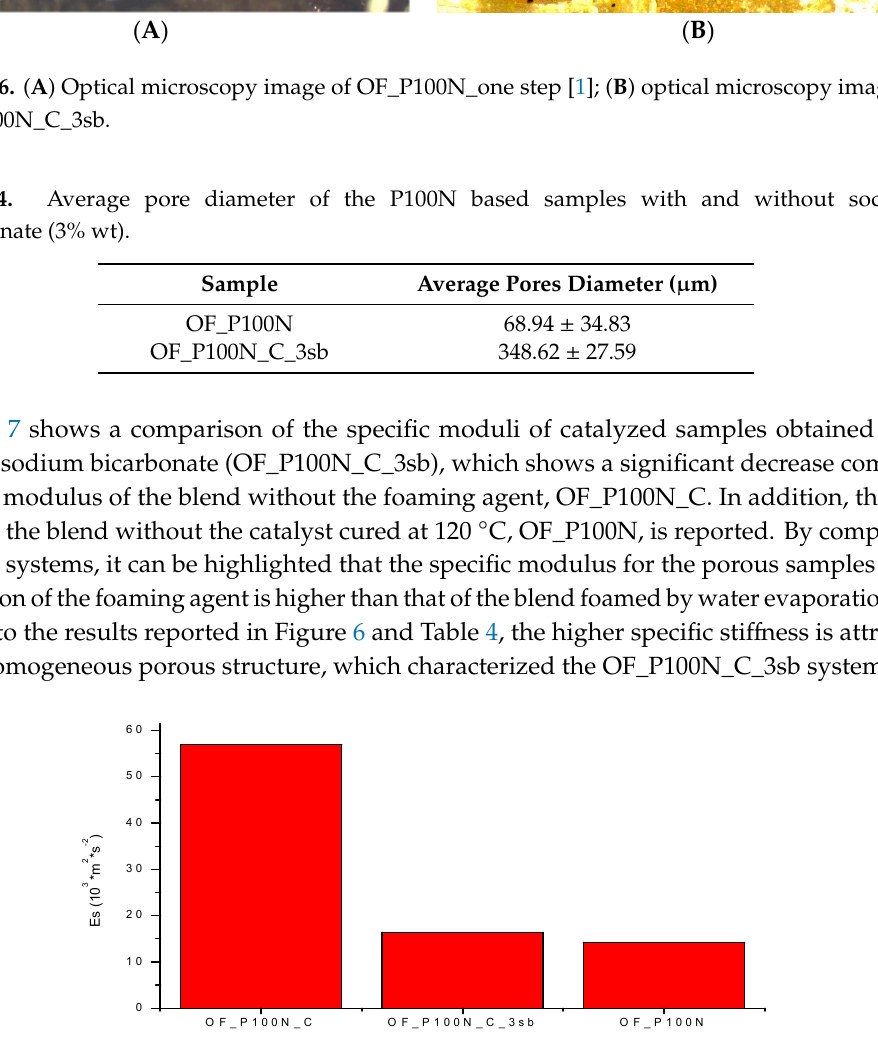
Figure 7. Comparison of specific modulus for the uncatalyzed and catalysed OF_P100N systems with OF_P100N_3sb.